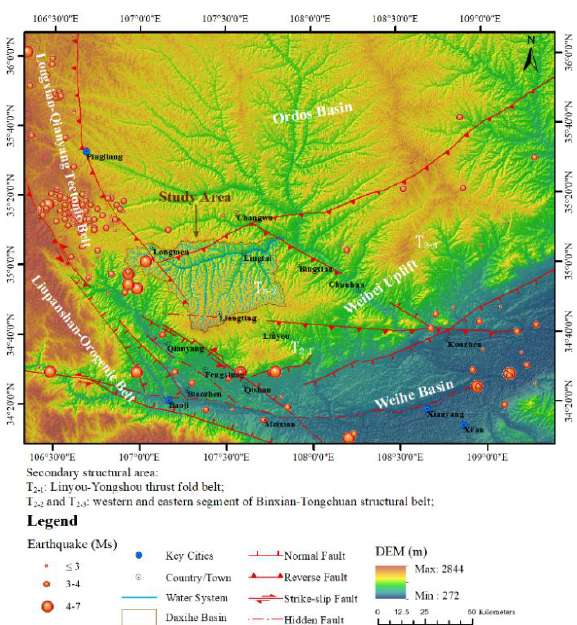
Figure 1. Regional geomorphic and active fault distribution map of study area. The faults and seismic data are from Fan et al., (2016). The SRTM1 data is available at https://earthexplorer.usgs.gov.